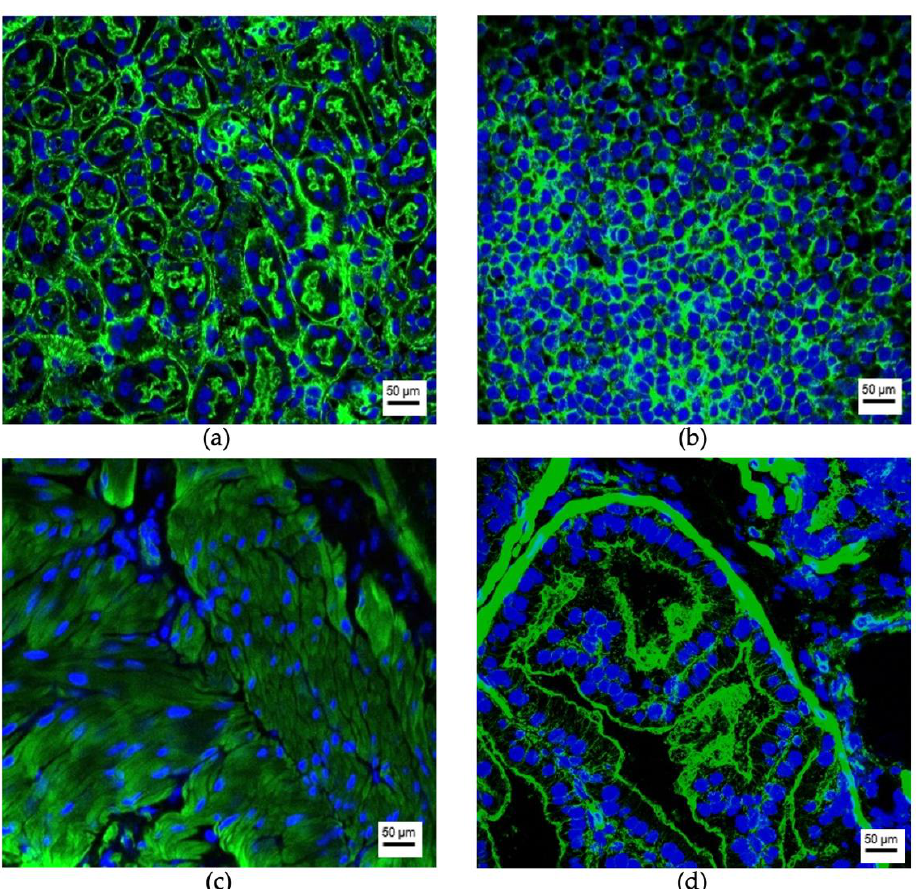
Figure 4. EV-negative organs after intravenous injection of fluorescence labeled EVs. Representative images of the kidney ( a ), the adrenal ( b ), the urinary bladder ( c ) and the prostate ( d ) 12 h after intravenous EV injection (from VCaP cells) are shown. The cytoskeleton of the cells is marked in green (Phalloidin-Alexa488) and their nuclei are marked in blue (DAPI). EVs would appear in red (PKH26). Resolution 200-fold; scale bar = 50 μm.